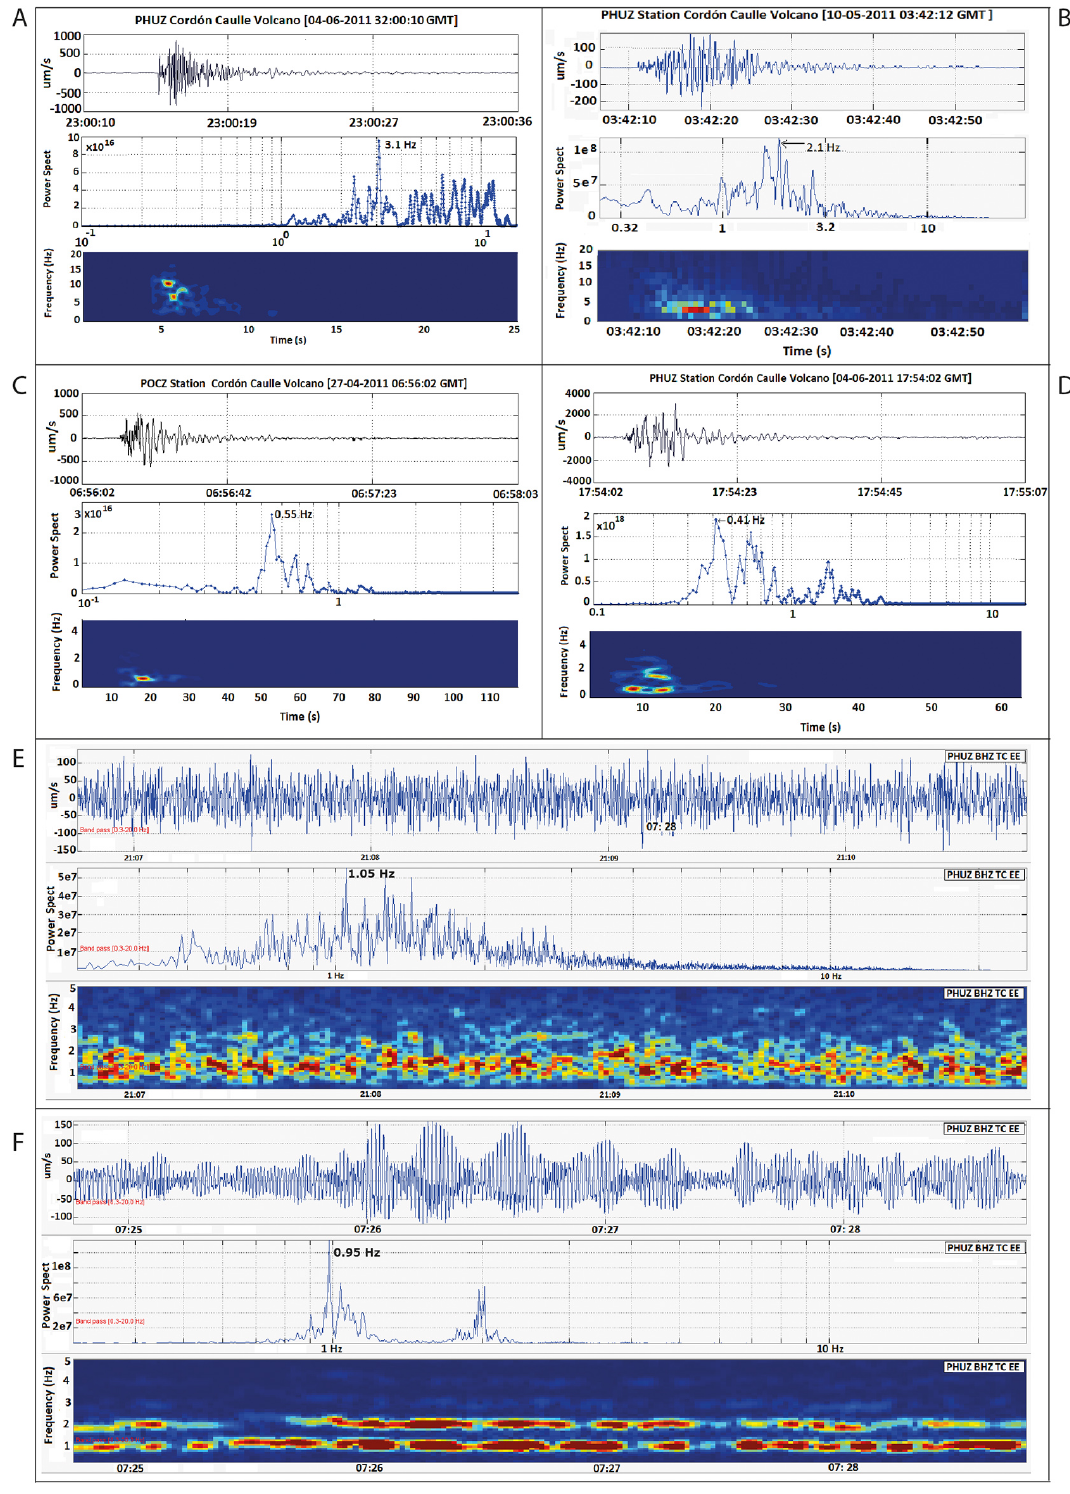
Figure 2. Selected examples of different seismic signals recorded at station PHU (with the exception of C recorded at station POC). Each panel has three graphs: the upper graph shows the velocity seismograms in the vertical component, the middle graph shows power spectra of the signal in a frequency range commonly between 0.1 and 10Hz, and the lower graph shows a spectrogram of the frequency content in time, with more reddish colors indicating high energy concentration. (a) Volcano–tectonic (VT) event. (b) Long-period (LP) event. (c) Hybrid (HB) event. (d) Very-long-period (VLP) event. (e) Spasmodic tremor recorded during the explosive phase of the eruption. (f) Quasi-harmonic tremor recorded during the effusive phase of the